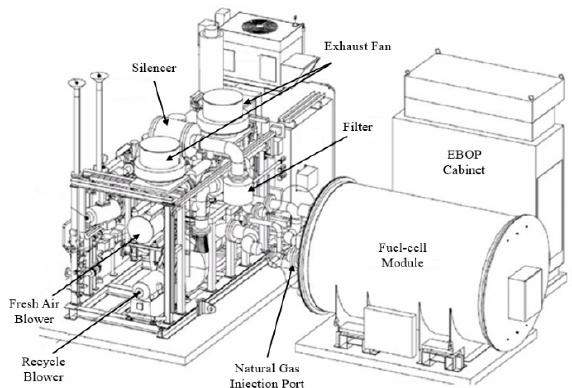
Figure 4. Overall configuration for fuel cell system.